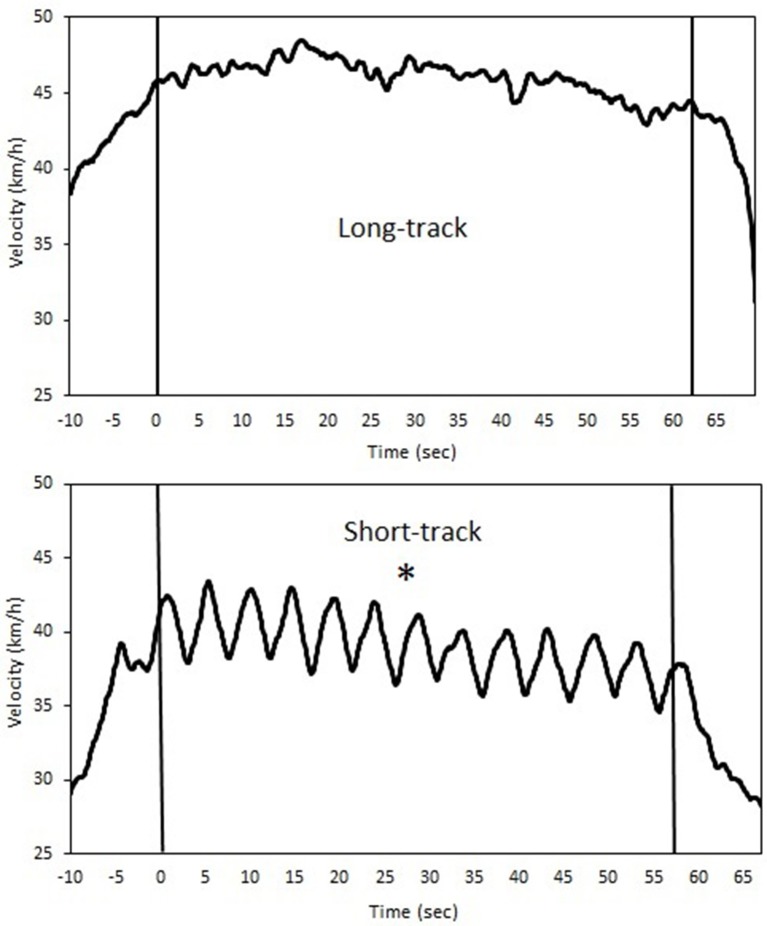
A typical example of the velocity profiles during both long-track (upper panel) as well as short-track (lower panel) speed skating for a single time-trial (*indicates a significant difference between skating modes for velocity and acceleration, p < 0.05).